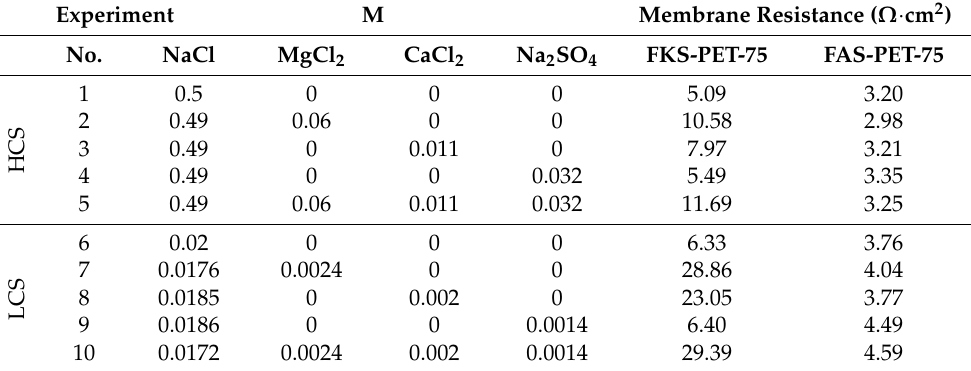
Table 2. Membrane resistance values ( Ω · cm 2 ) for FKS and FAS in high- and low-concentration solutions